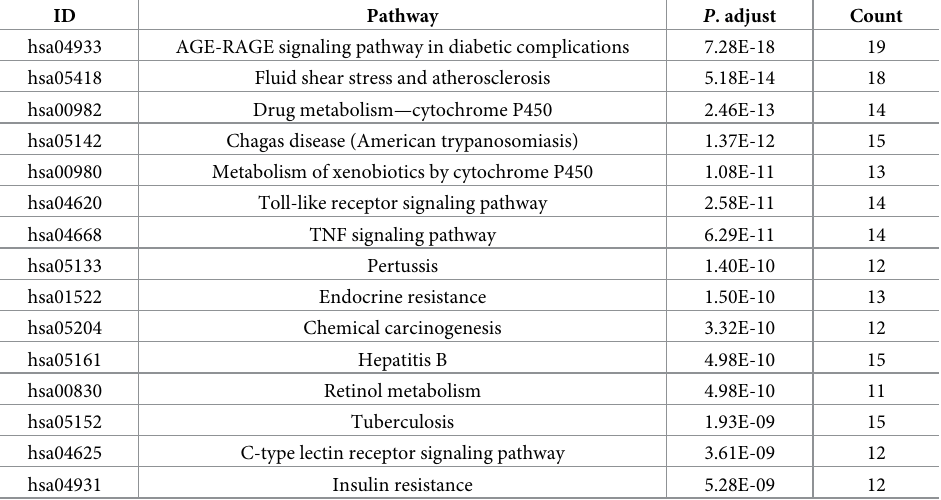
Table 4. Top 15 KEGG pathways for SHCZF against cholestasis.